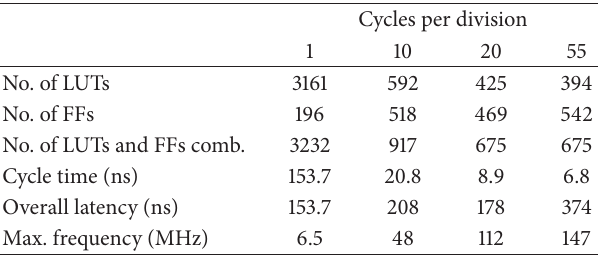
Table 7: Postplace and route result of a 64-bit binary floating-point divider (Core